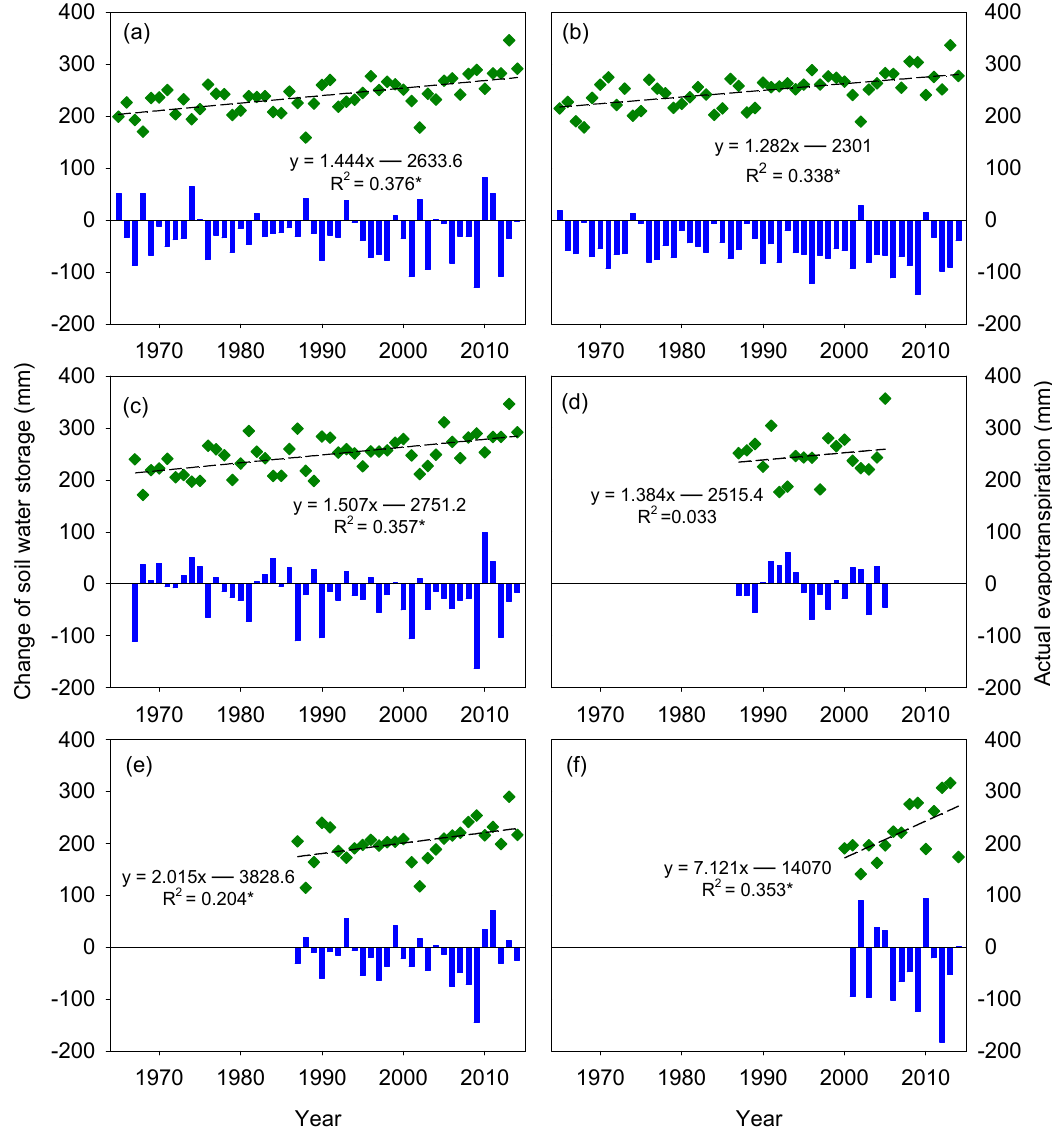
Figure 6. Variations of soil water storage and actual evapotranspiration for six crops in Saskatchewan from 1965 to 2014. ( a ) spring wheat; ( b ) barley; ( c ) canola; ( d ) sunflower; ( e ) lentil; ( f ) chickpea. Note: * Significant difference at the 0.05